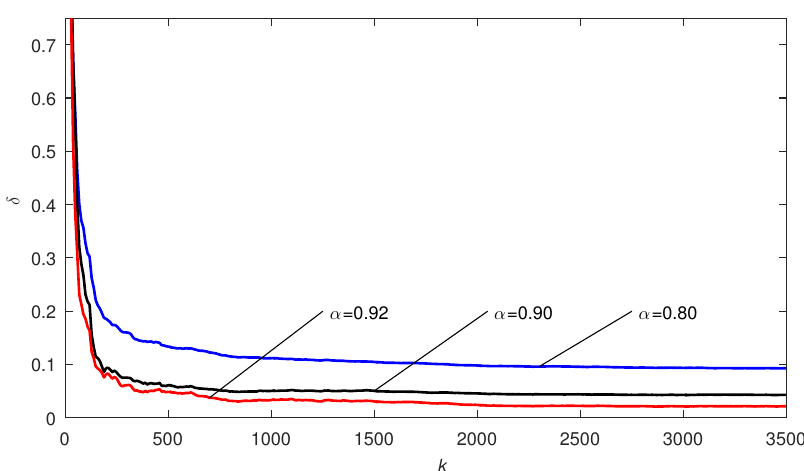
Figure 4. The AM-MIFSG estimation error δ versus k with α = 0.80, 0.90 and 0.92 ( p = 5).